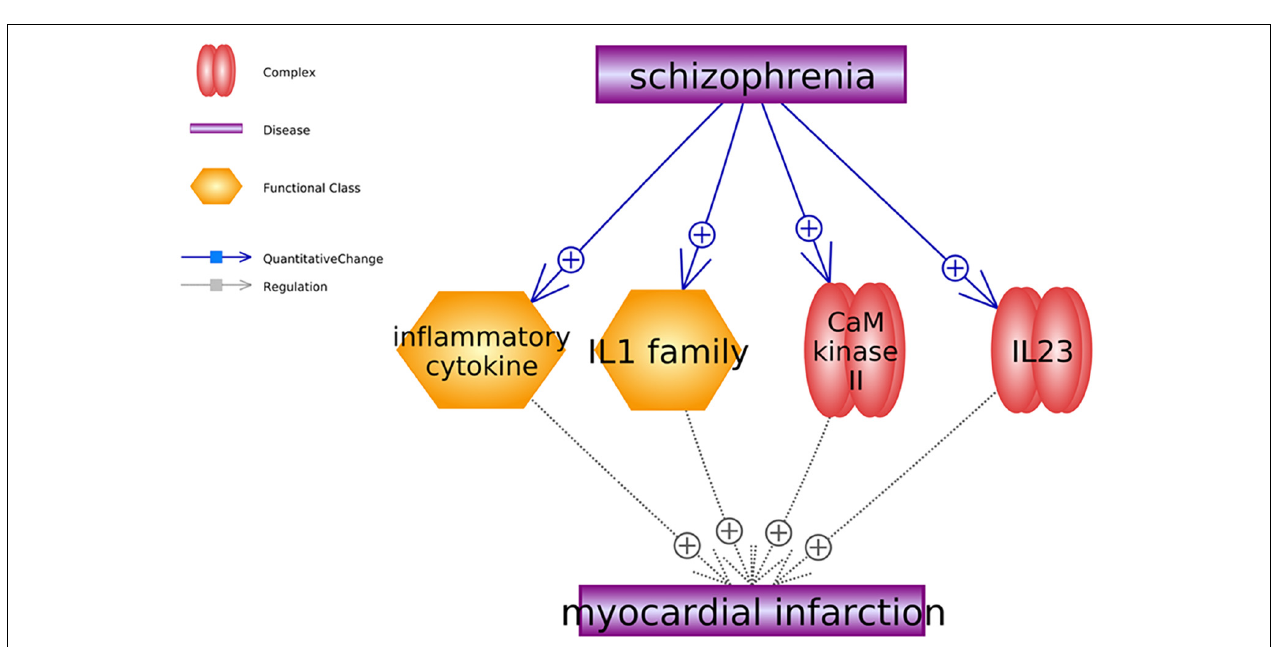
FIGURE 3 | Schizophrenia-driven cells, gene families and complex as regulators of myocardial infarction. Each relationship was supported by three or more references. The network contains two types of relationships (quantitative change and